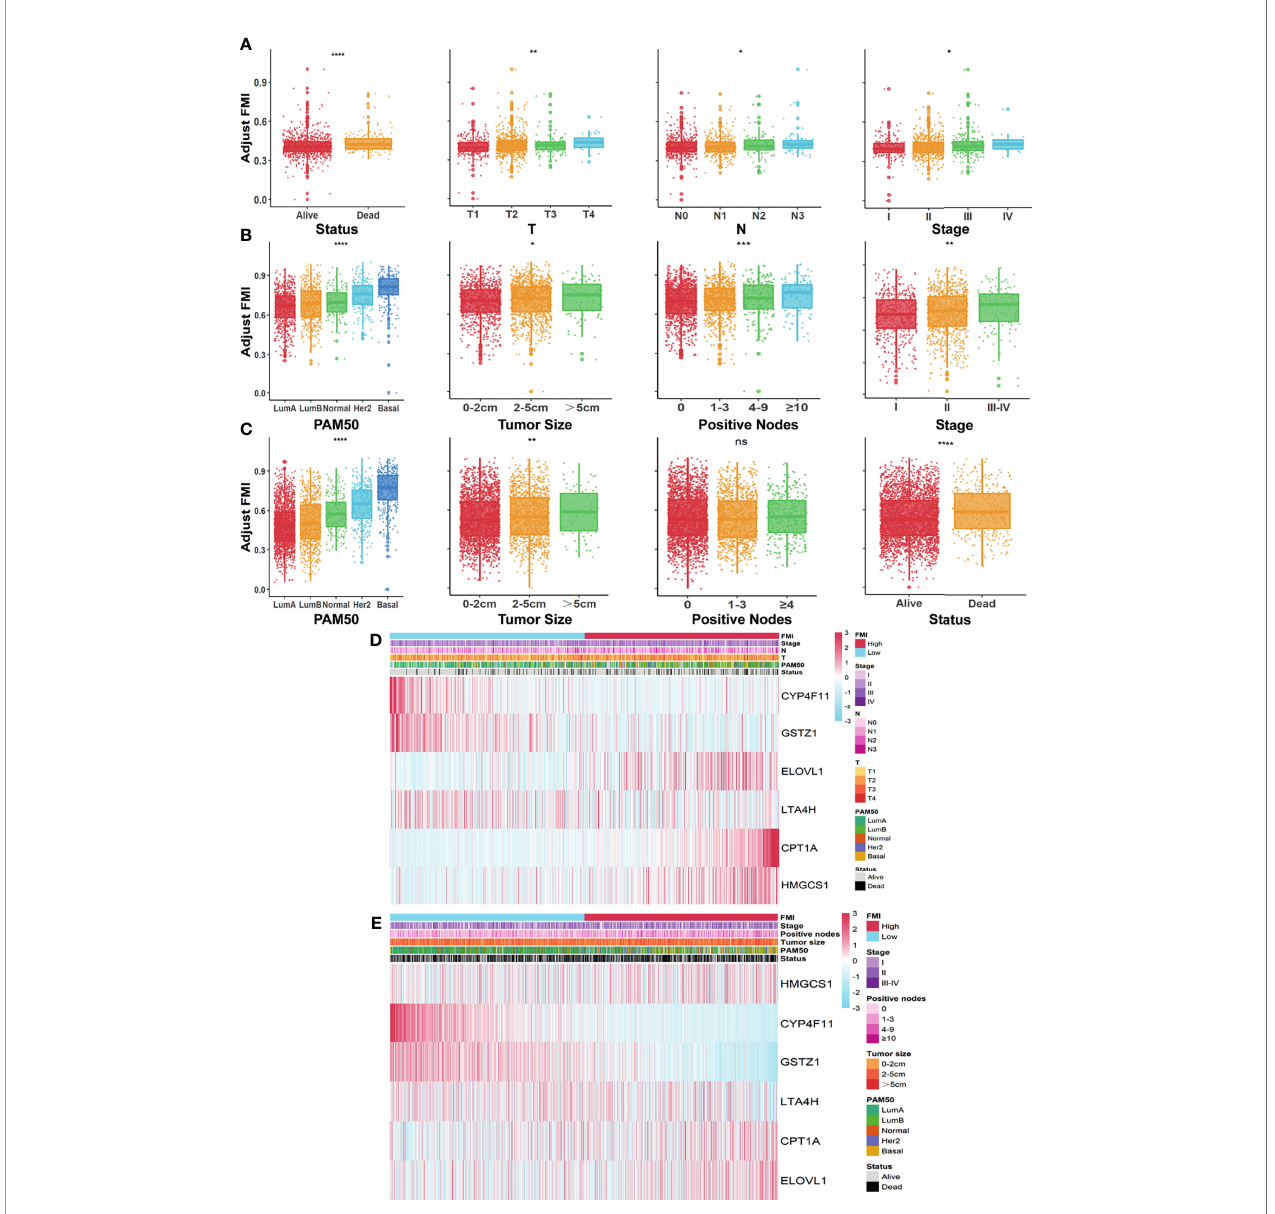
FIGURE 4 | Systematic assessment of FMI and clinical parameters in BC patients. Comparison of adjusted FMI in various degrees of diverse clinical parameters in TGCA-BRCA (A) , METABRIC (B) , and GSE96058 (C) datasets. Heatmaps integrating FMI and clinical parameters in training set (D) and in METABRIC cohort (E) . FMI, fatty acid metabolism index; BC, breast cancer; TCGA, The Cancer Genome Atlas; METABRIC, Molecular Taxonomy of Breast Cancer International Consortium. *Means p < 0.05; ** means p < 0.01; *** means p < 0.001; **** means p < 0.0001; ns means no signi fi